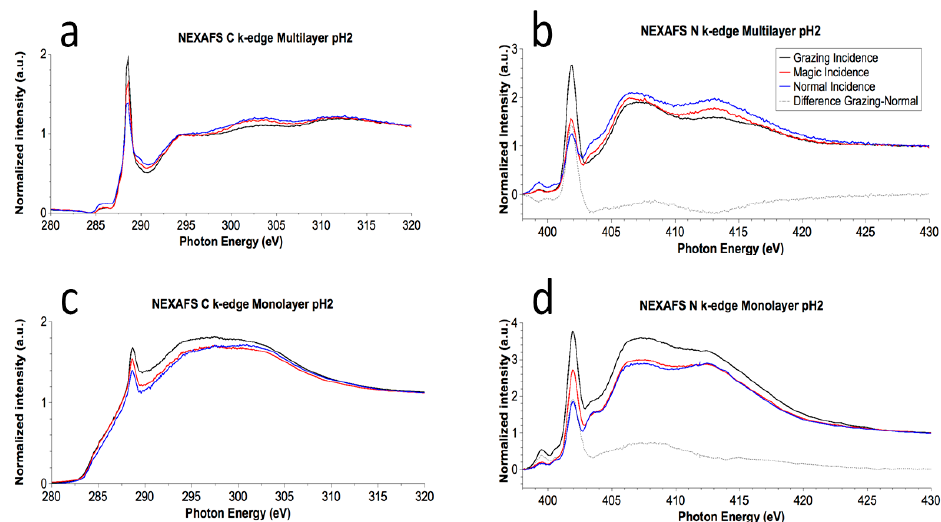
Figure 8. ( a ) C K-edge Near Edge X-ray Absorption Fine Structure (NEXAFS) spectrum of EAbuK multilayer deposited at pH = 2; ( b ) N K-edge NEXAFS spectrum of EAbuK at pH = 2; ( c ) C K-edge NEXAFS spectrum of EAbuK monolayer deposited at pH = 2; ( d ) N K-edge NEXAFS spectrum of EAbuK monolayer at pH = 2.